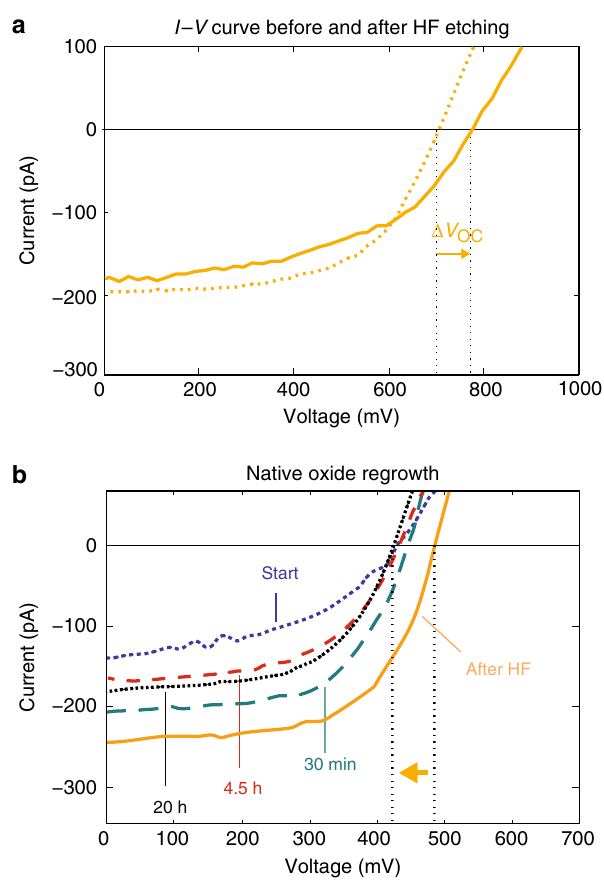
Fig. 3 Effect of HF etching on the V OC . a I − V curve before (dashed line) and after (solid line) HF etching. b The I − V curves of a second sample show the effect of the native oxide regrowth. After the initial increase in performance (yellow), the native oxide slowly grows back (cyan, red, black), reducing the V OC . The vertical dashed lines are guides for the